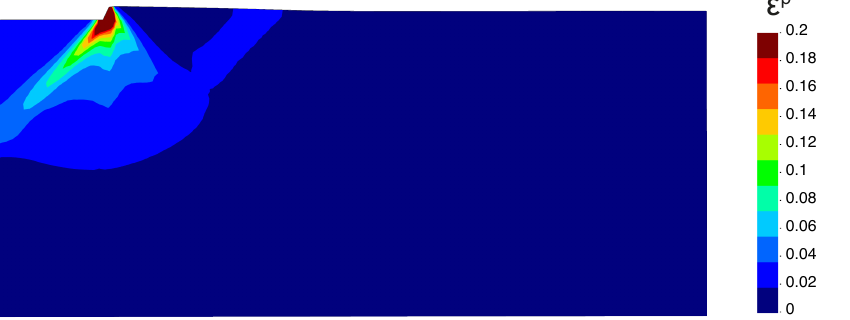
Figure 8. Equivalent plastic deformation of the footing problem using von Mises law with softening through degradation at the final of the